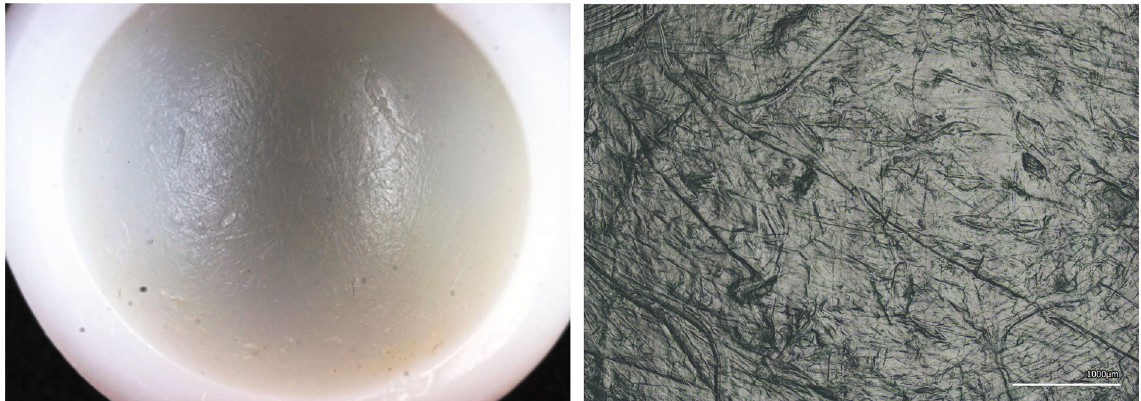
Figure 7: (a) View of the articulating surface of the PE cup liner with multidirectional scratches and (b) pitting magni fi cation of the local surface damage.